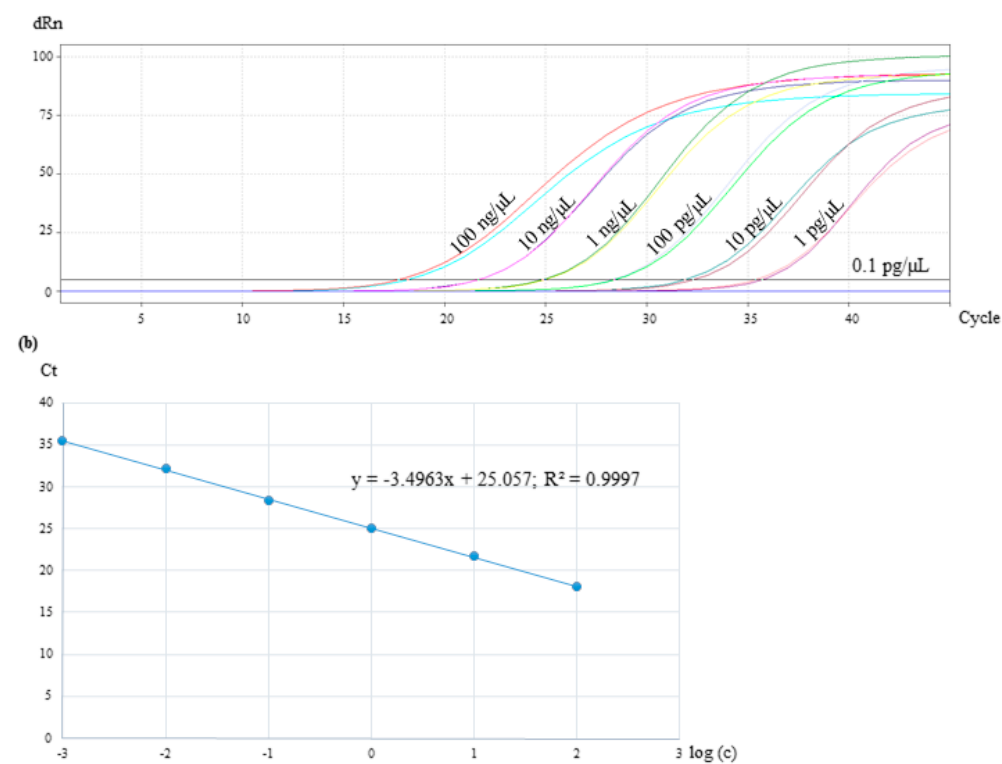
Figure 4. Sensitivity test of the real-time PCR assay with 10-fold diluted DNA of coconut in a concentration range from 100 ng / µ L to 0.1 pg / µ L. The reactions were performed in duplicates. ( a ) The amplification plot shows C t values for samples from 100 ng / µ L to 1 pg / µ L. ( b ) Standard curve of the coconut TagMan real-time PCR system by plotting C t values against the log 10 input DNA concentration.